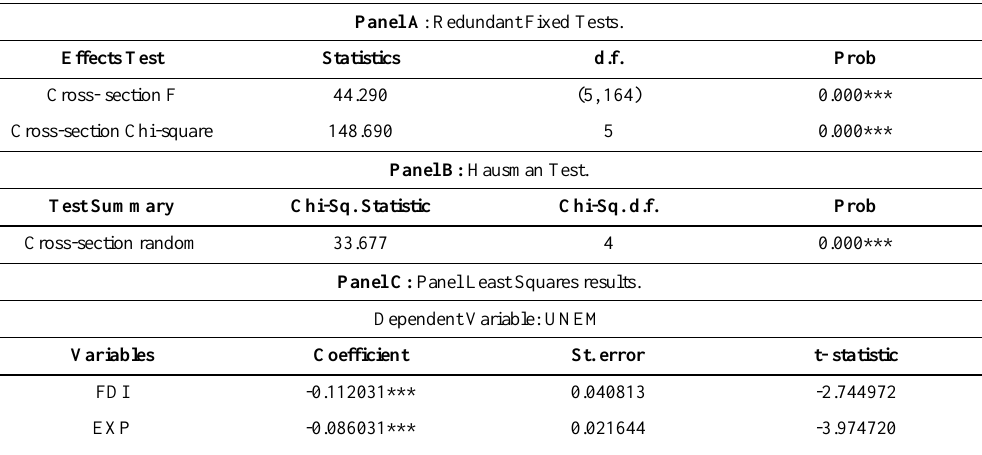
Table 8. Fixed Effect Model (FEM) estimation and test results. Panel A : Redundant Fixed